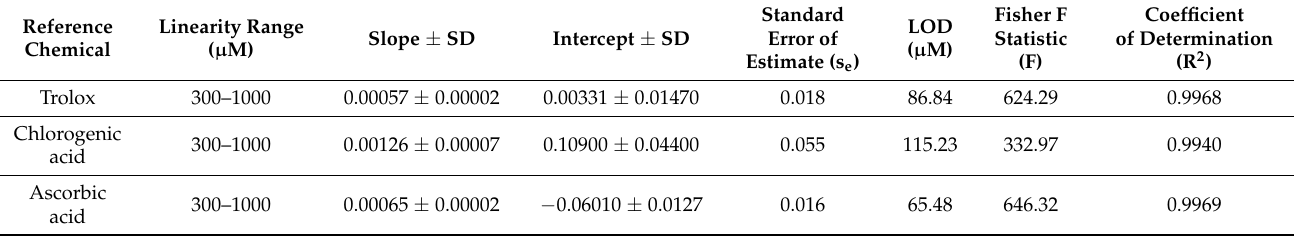
Table 1. Linear regression parameters for the calibration curves represented blank corrected absorbance vs. concentration